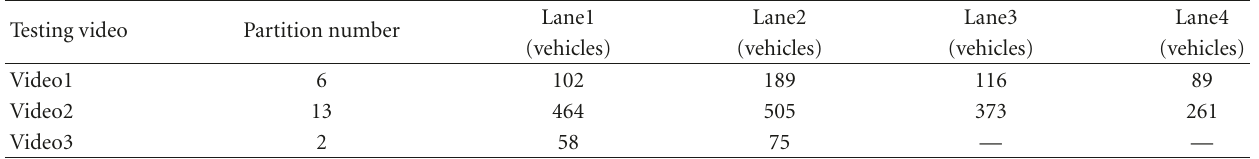
Table 2: Number of passing vehicles in each